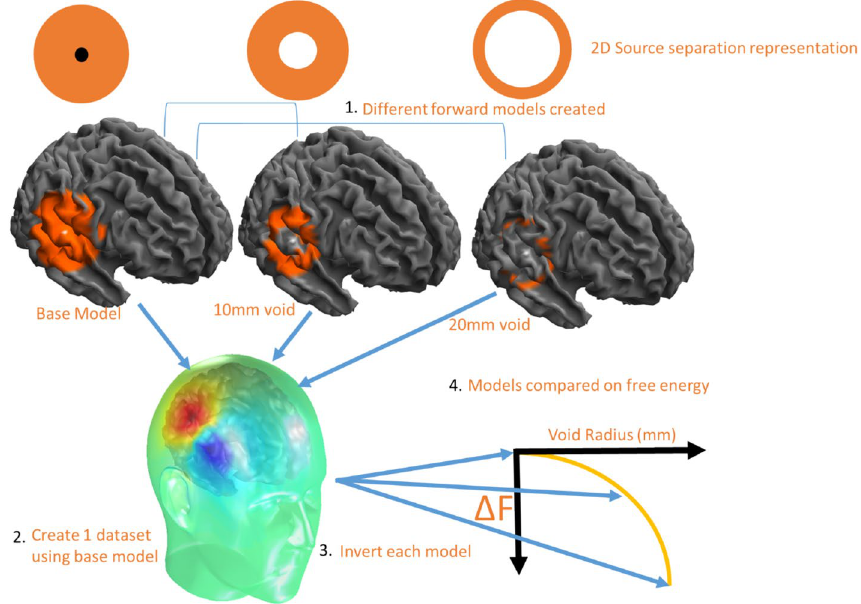
Figure 1. Model comparison and spatial discrimination. Different forward (or target) models are created that map to brain regions that are progressively more distant to the true generator source (at centre of circle). A 2D representation is provided with the source in black and the candidate models in orange (the contents of the lead field matrix). We then reconstruct the same MEG data onto all cortical models. Each fit has an associated model evidence or free energy value. As the void radius (excluded sources) increases, the models provide increasingly less likely (as quantified by log Free energy) explanations of the MEG data. The void radius (in mm) at which the target model is 20 times less likely (log (cid:31) F = − 3) is a measure of the spatial